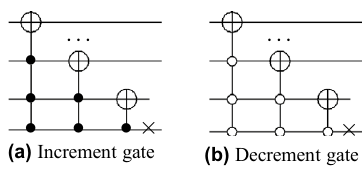
Figure 3. Increment and Decrement gates on n